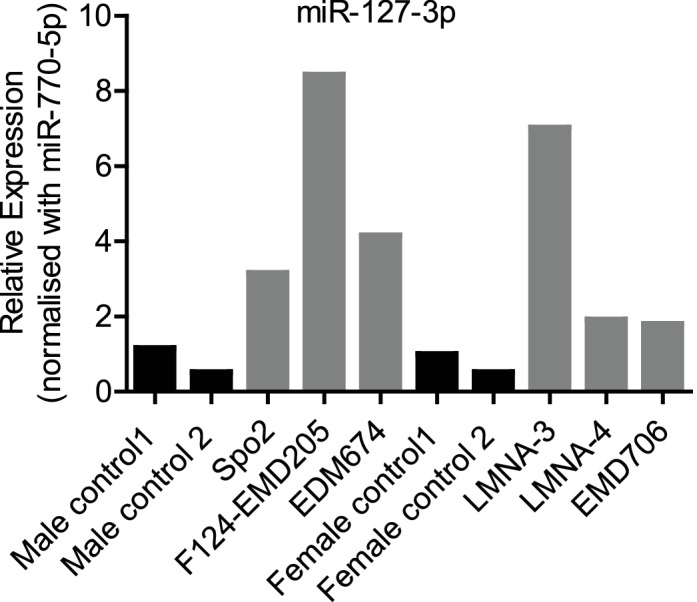
miR-127–3 p levels were quantified in healthy human biopsy samples and patients diagnosed with different LMNA mutations.Refer to Supplementary file 2 for the list of LMNA patient mutations and their associated pathologies.